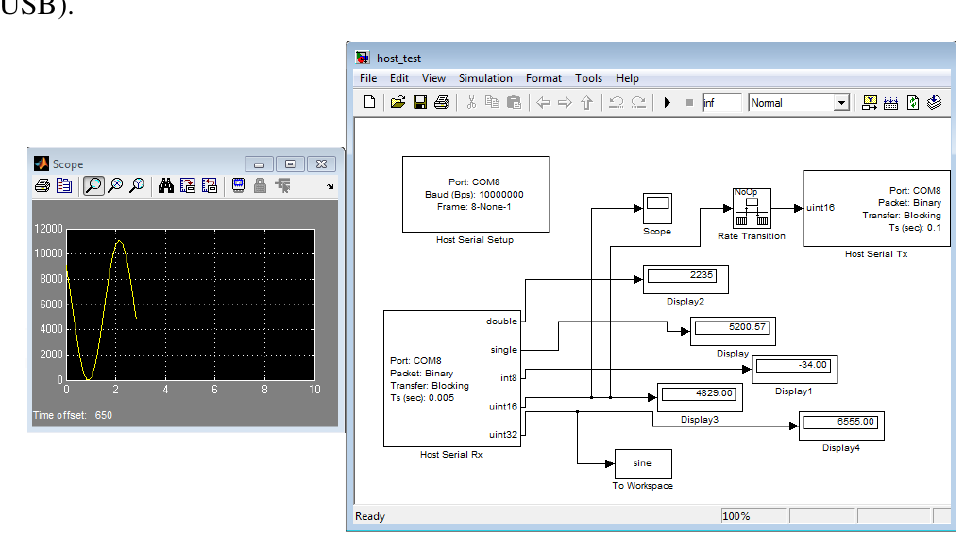
Figure 3. The Simulink R (cid:13) graphical programming environment, a simple data acquisition program, reading and storing data received from an STM32F4 target via universal serial bus